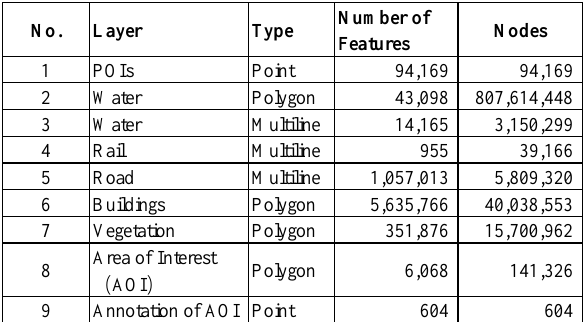
Table 2. Layers and features of the experimental dataset